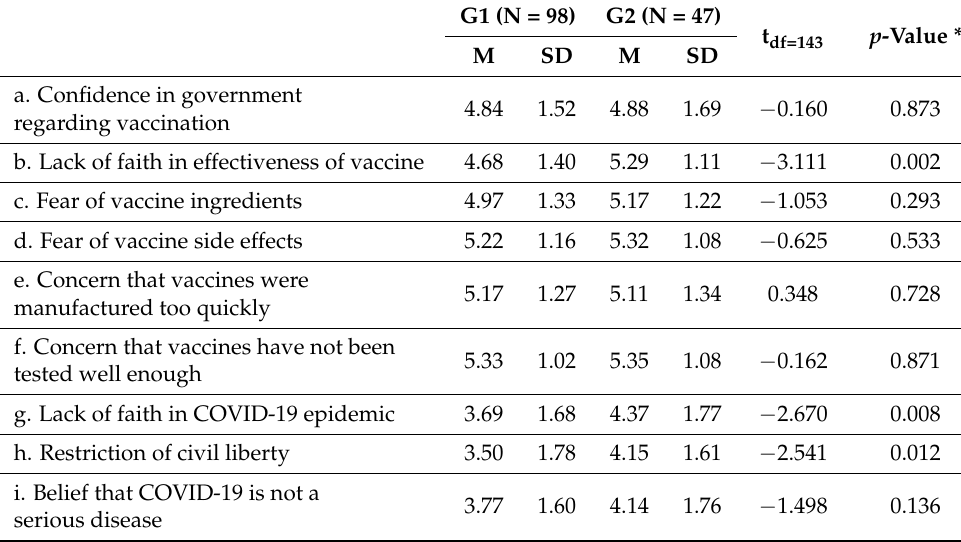
Table 7. Perception of causes of non-vaccination in Polish